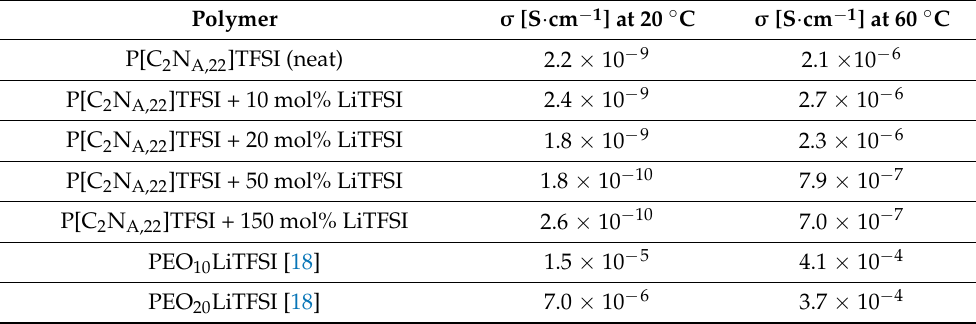
Table 3. Ionic conductivity values of P[C 2 N A,22 ]TFSI with varying LiTFSI concentrations compared to literature results for PEO-LiTFSI membranes. Literature values taken from